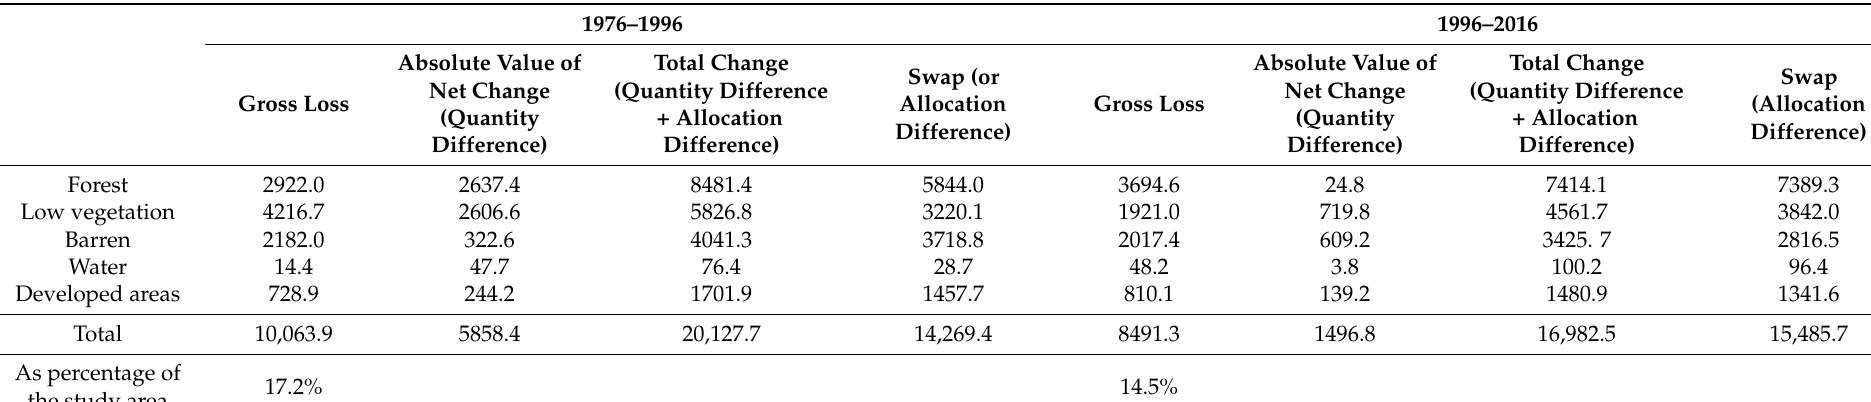
Table 10. Total Change, Net Change, and Swap values for the two intervals. Values are in